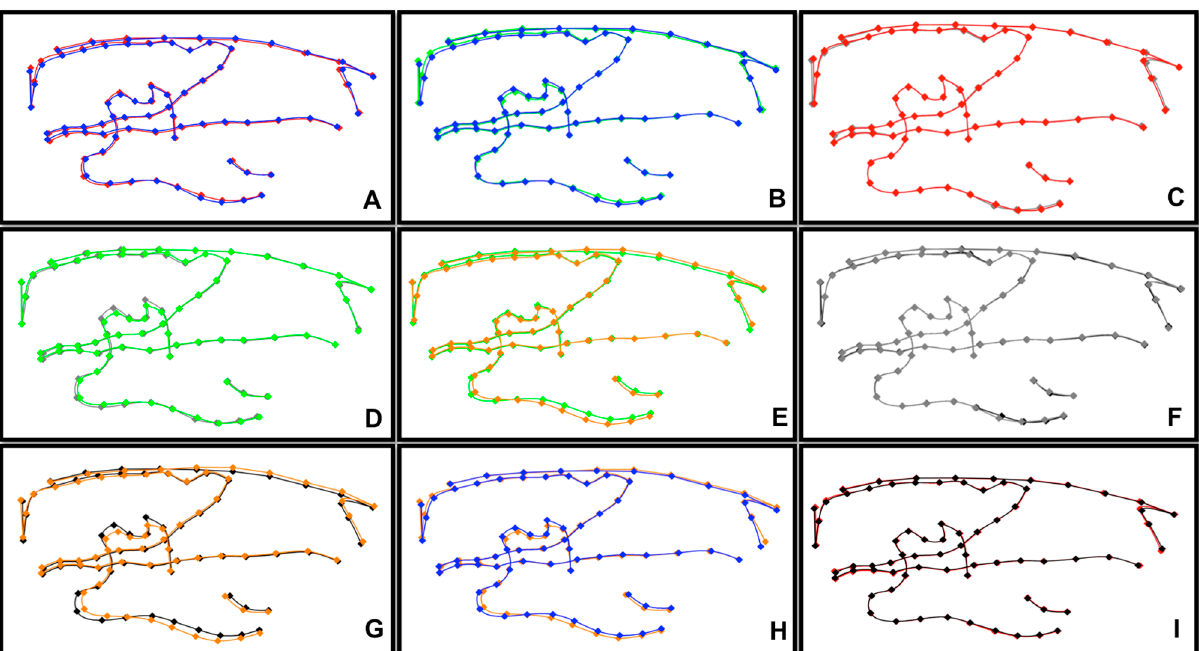
Figure 4. Corresponding superimposition of all means. ( A ) S1 vs. H1 ( p = 0.002), ( B ) S1 vs. S2 ( p = 0.048), ( C ) H1 vs. H2 ( p = 0.054), ( D ) S2 vs. H2 ( p = 0.001), ( E ) S2 vs. S3 ( p = 0.001), ( F ) H2 vs. H3 ( p = 0.41), ( G ) S3 vs. H3 ( p = 0.001), ( H ) S1 vs. S3 ( p = 0.01), ( I ) H1 vs. H3 ( p = 0.083).